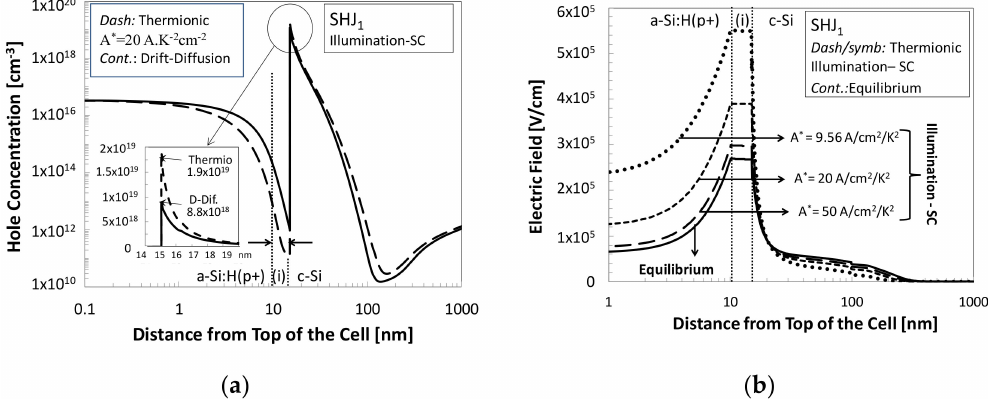
Figure 7. Results of AFORS-HET simulations of cell SHJ 1 under illumination-SC: ( a ) hole concentration profile assuming thermionic emission with A * = 20 A K − 2 cm − 2 ( Dash ) and with drift-diffusion ( Cont. ); ( b ) electric field distribution with A * = 9.56 (default), 20 and 50 A/K − 2 cm − 2 and at equilibrium ( Cont.